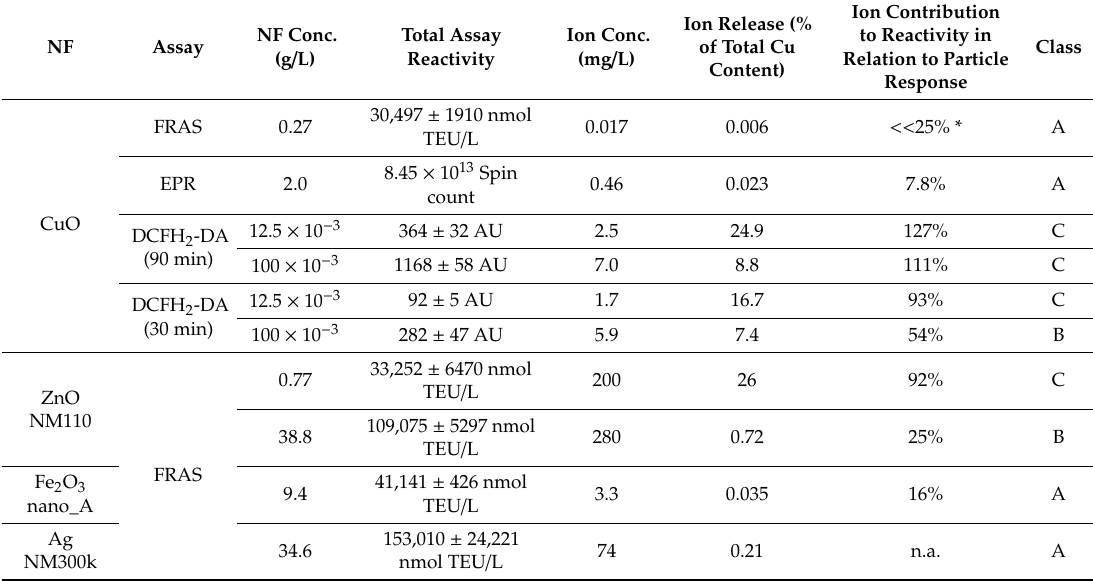
Table 1. Summary of reactivity data for NFs and related ions in the three